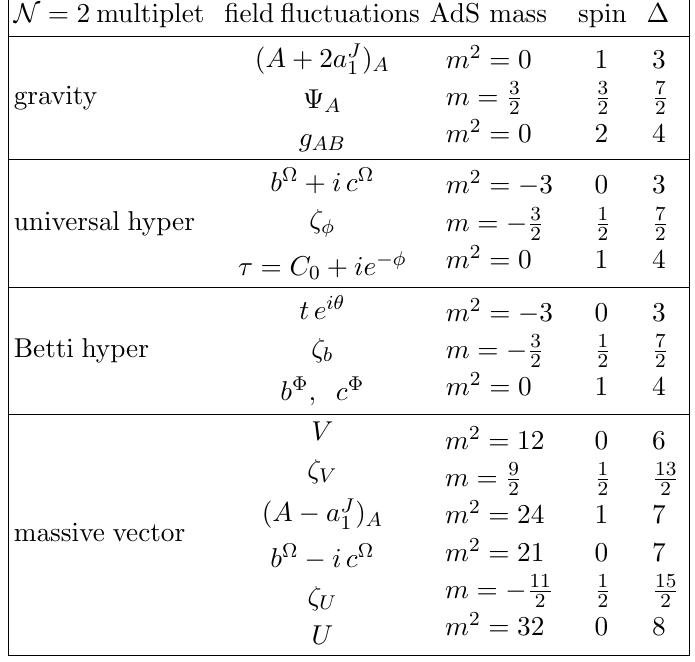
Table 3 . Mass spectrum of bosons and fermions in the N = 2 ; Z 2 truncation of [19] around